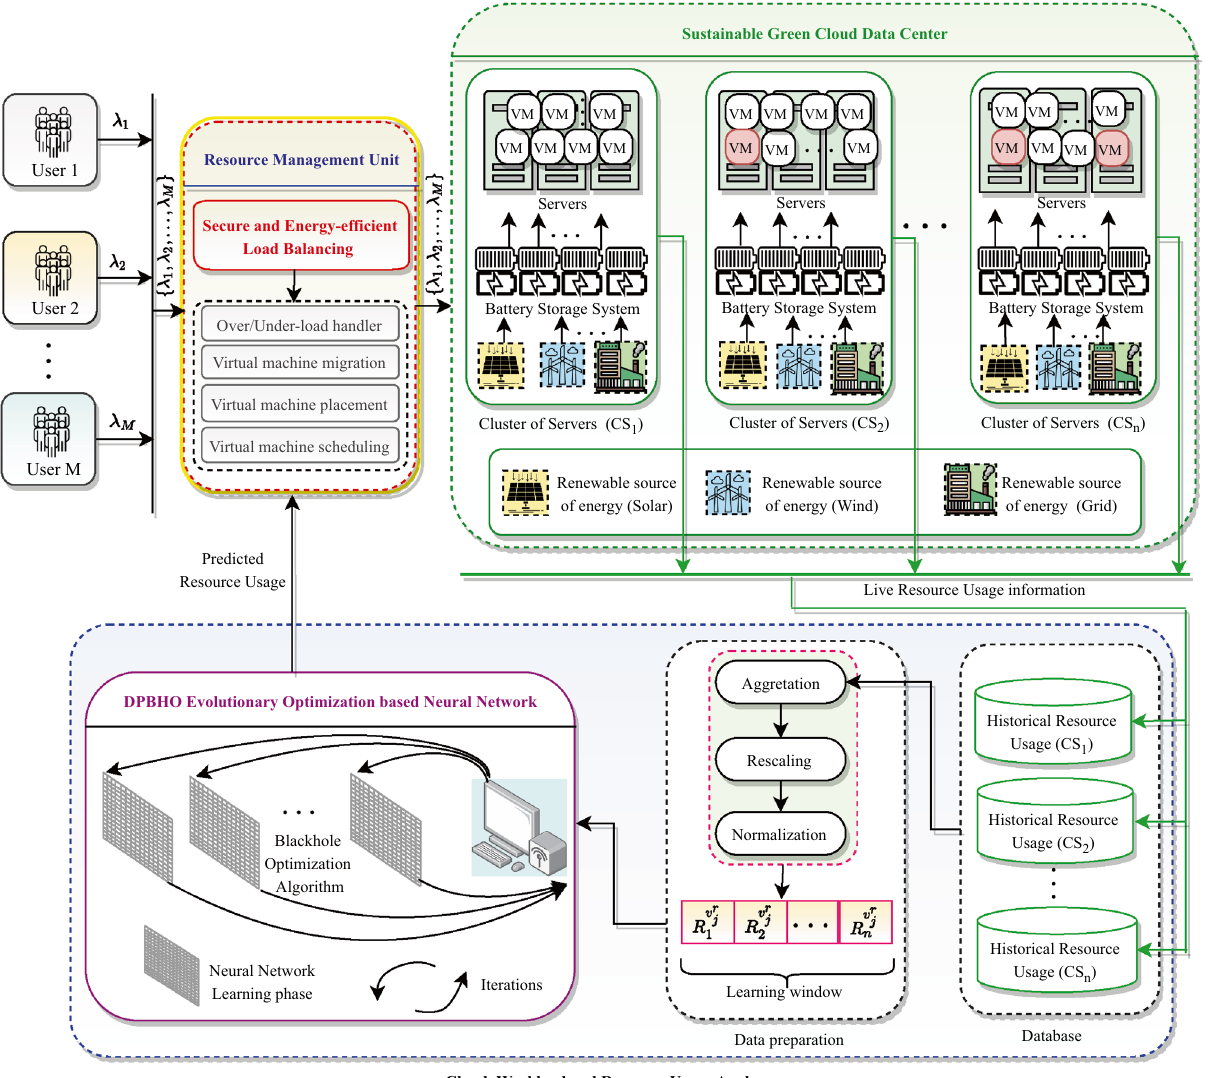
Figure 7. System architecture of the proposed